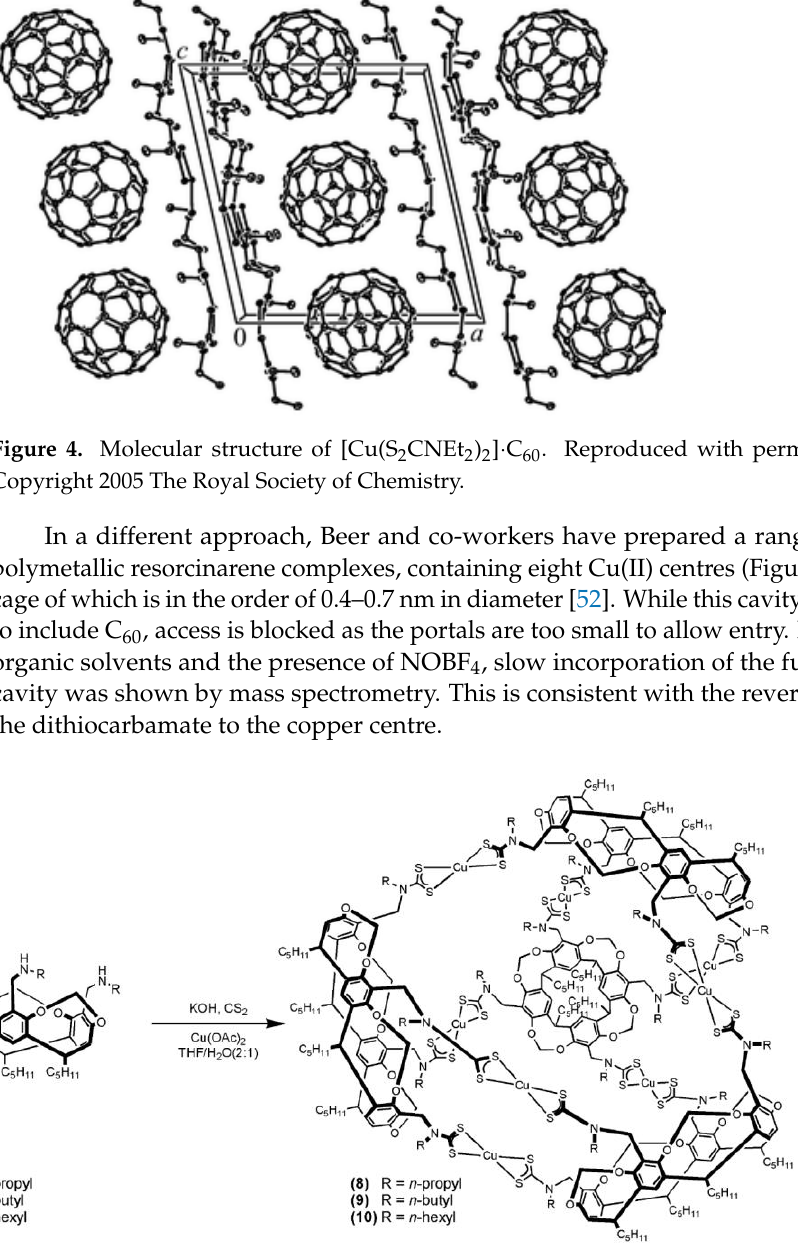
Figure 5. Formation of nanoscale resorcinarene complexes containing Cu(II) bis(dithiocarbamate) centres. Reproduced with permission from [52]. Copyright 2006 American Chemical Society.